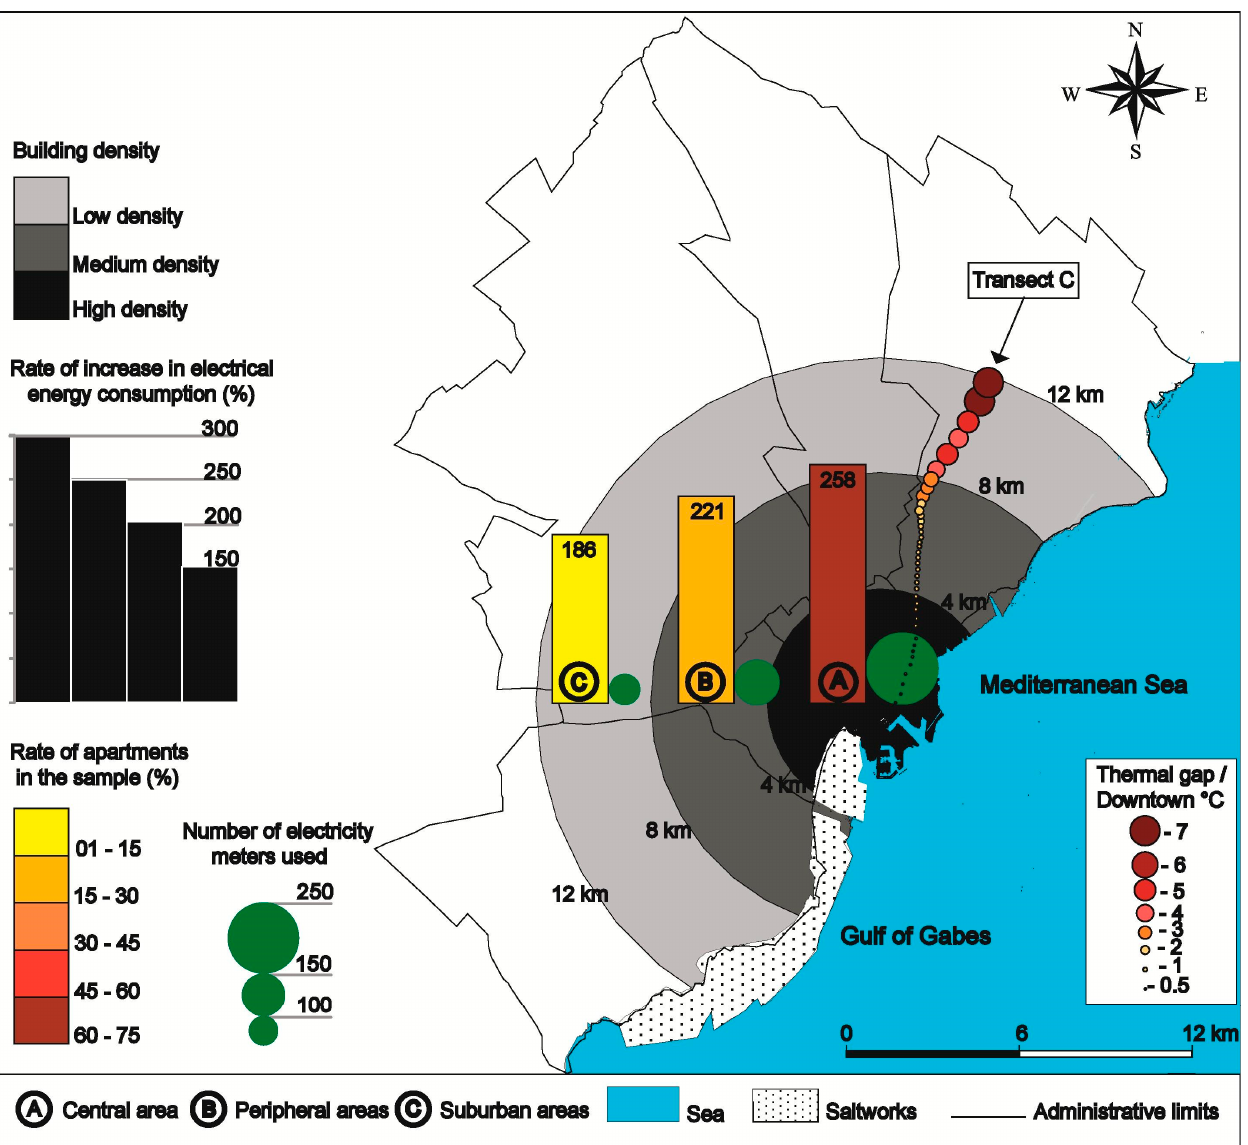
Figure 5. Spatial distribution of building density, number of electricity meters used, rates of apart- ments in the samples used in areas A, B and C and percentages of the average increase in electrical energy consumption in the conurbation of Sfax between the months of May and August 2018.